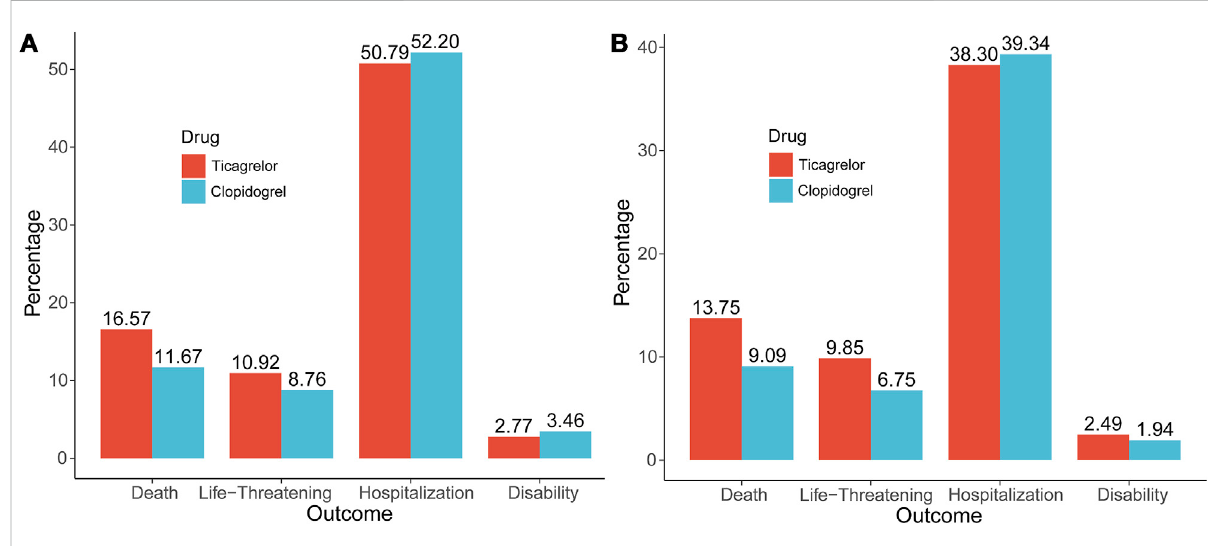
FIGURE 1 The Outcome indicators of ticagrelor and clopidogrel. (A) Overall outcome indicators; (B) Outcome indicators of hemorrhagic signals.